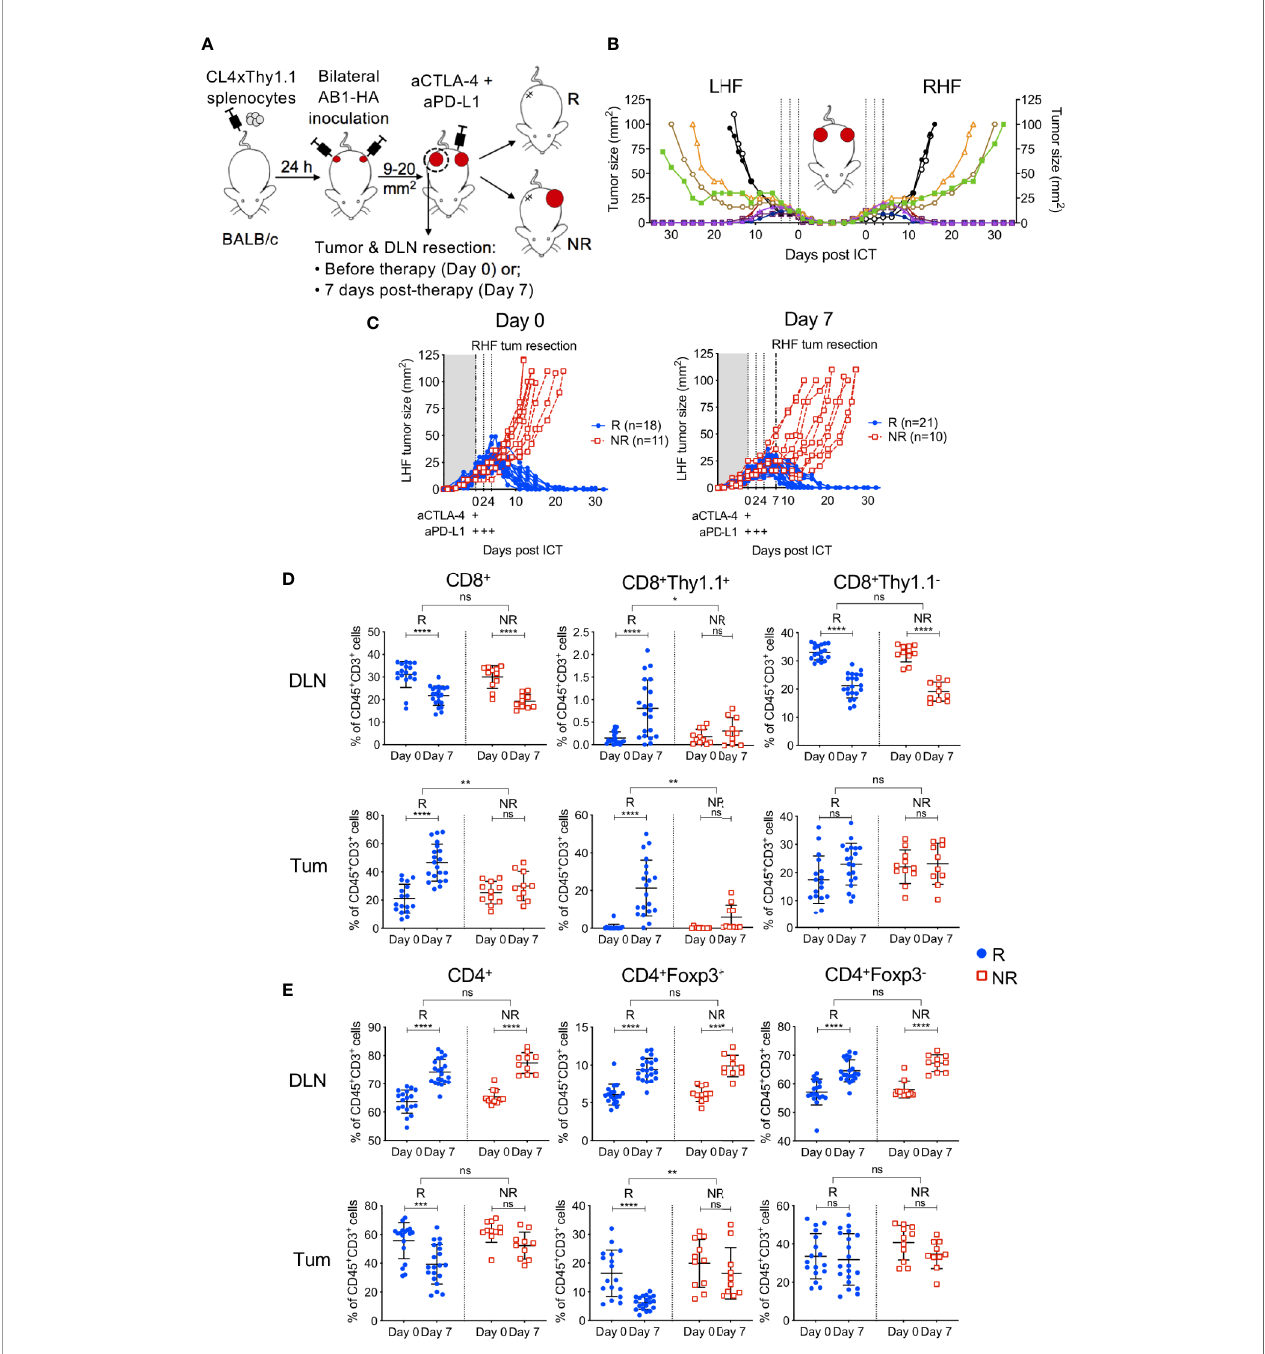
FIGURE 2 | Tumor antigen-speci fi c CD8 + T cells increase in ICT responding DLN and tumors. (A) Experimental timeline. CL4xThy1.1 splenocytes were adoptively transferred into BALB/c mice one day prior to bilateral AB1-HA tumor inoculation. Right-hand fl ank (RHF) tumor (Tum) and draining lymph node (DLN) were surgically resected either pre- (day 0) or post-ICT (day 7). Left-hand fl ank (LHF) tumor was followed for ICT response. (B) Growth curves representing symmetrical growth and regression of bilateral AB1-HA tumors treated with ICT (n = 8; color-coded per mouse) or PBS (n = 2; black), without surgery. Dotted lines indicate days of treatment. (C) Growth curves of LHF tumors for mice that had their RHF tumors and DLNs resected at day 0 (left) or day 7 (right). Mice were characterized as responders (R; blue) or non-responders (NR; red). Dotted lines indicate days of treatment. Pre (Day 0) and post (day 7) treatment frequencies of total CD8 + , CD8 + Thy1.1 + and CD8 + Thy1.1 − (D); total CD4 + , CD4 + Foxp3 + and CD4 + Foxp3 - T cells (E) in resected DLNs (top) and tumors (bottom) of responding and non- responders. Data represented as mean ± SD, summary of fi ve independent experiments. Two-way ANOVAs were used to compare the magnitude of difference between responders and non-responders, with Tukey ’ s multiple-comparisons to compare pre- and post-treatment frequencies within each group; *P ≤ 0.05, **P ≤ 0.01, ***P ≤ 0.001, ****P ≤